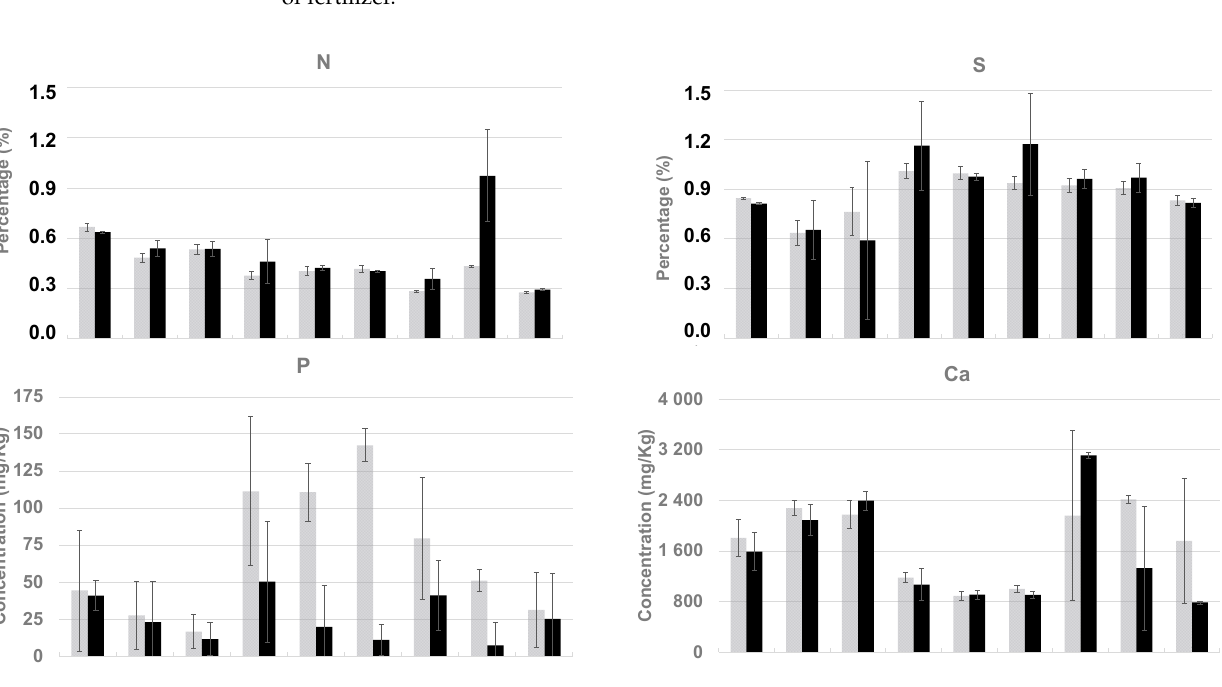
Figure 6. Nutrient contents from the leachate (collected after 23 weeks) for each substrate: 100% peat (P), 75% peat plus 25% bulk biochar (PB), 75% peat plus 25% bulk biochar impregnated with ammonium sulfate (PBAS), 75% peat plus 25% biochar pellets with water (PPeBW), 75% peat plus 25% biochar pellets with ammonium sulfate (PPeBAS) and 62.5% peat plus 25% biochar pellets with ammonium sulfate plus 12.5% perlite (PPeBASPer), with low (grey) and high doses (black) of fertilizer.